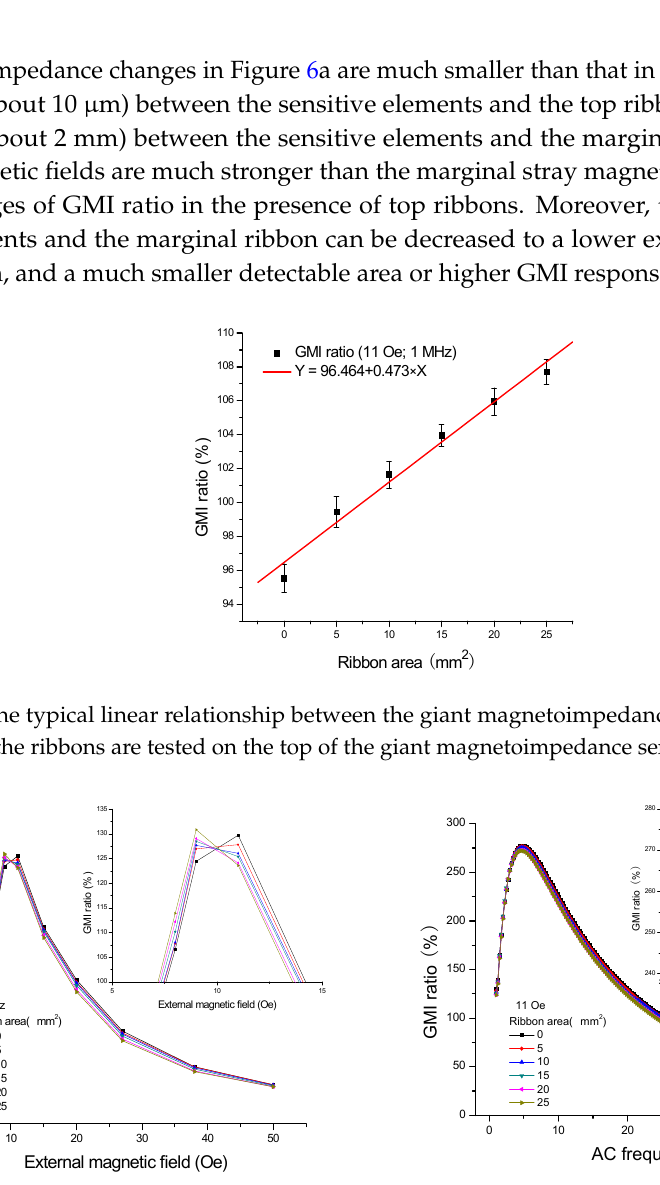
Figure 4. The giant magnetoimpedance responses when the ribbons are tested on the top of the giant magnetoimpedance sensor I: ( a ) field dependence and ( b ) frequency dependence.